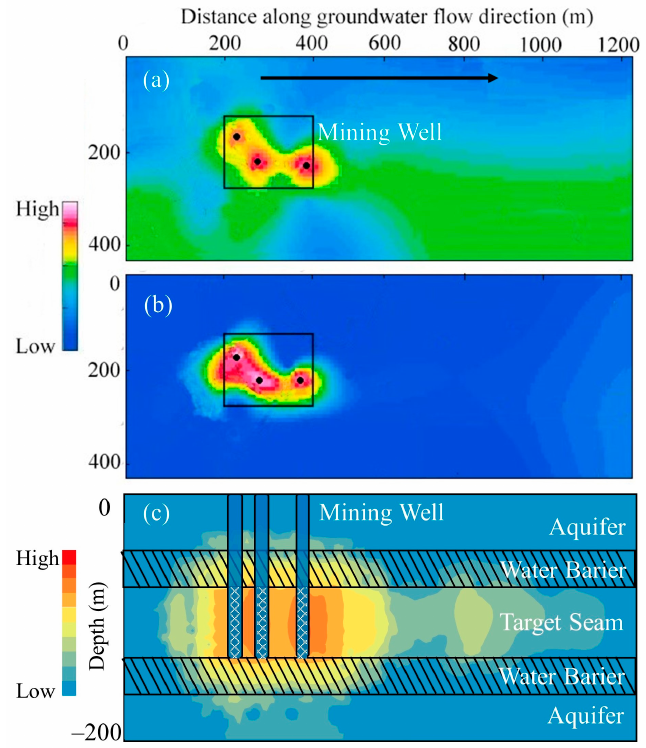
Figure 9. Schematic view of the groundwater pollution halo. The black square delineates the range of the mine, and the dots indicate the mining wells. ( a ) shows the pollution halo of primary high-concentration pollutants, such as SO 4 2 − , Fe, and U; ( b ) shows the horizontal pollution halo of low-concentration pollutants, such as Cl − , NO 3 − and other heavy metals; ( c ) shows the vertical pollution halo; the data were interpolated from the measurement of a decommissioned uranium mine in Northwest China.